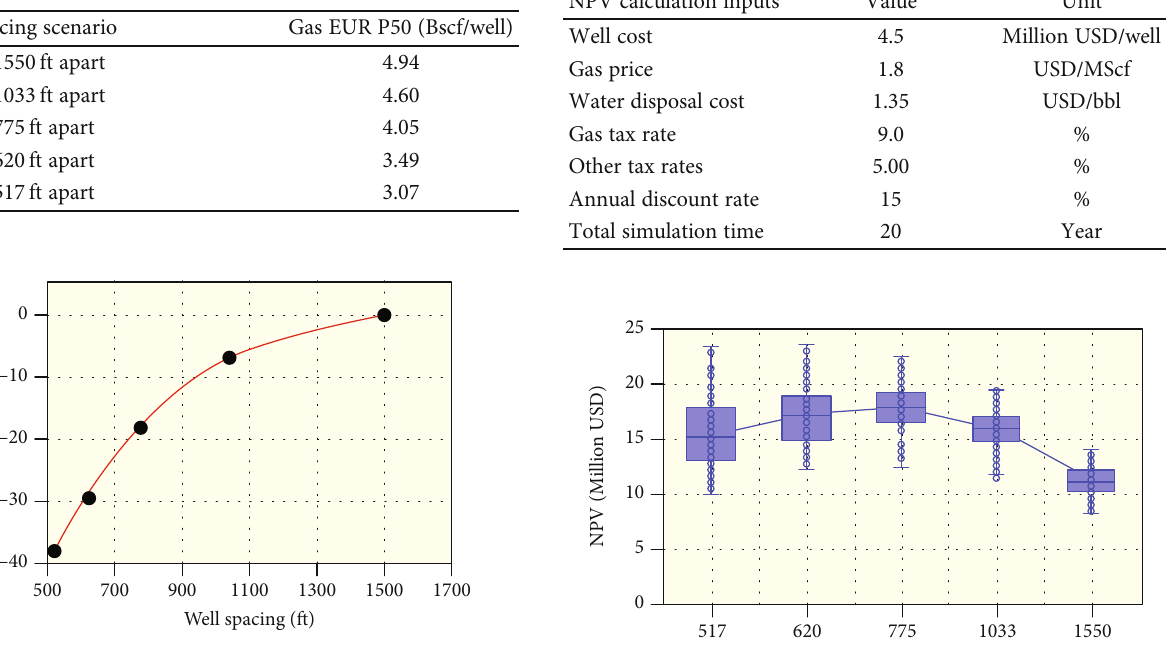
Figure 12: Gas EUR degradation of P50 with varying well spacing.